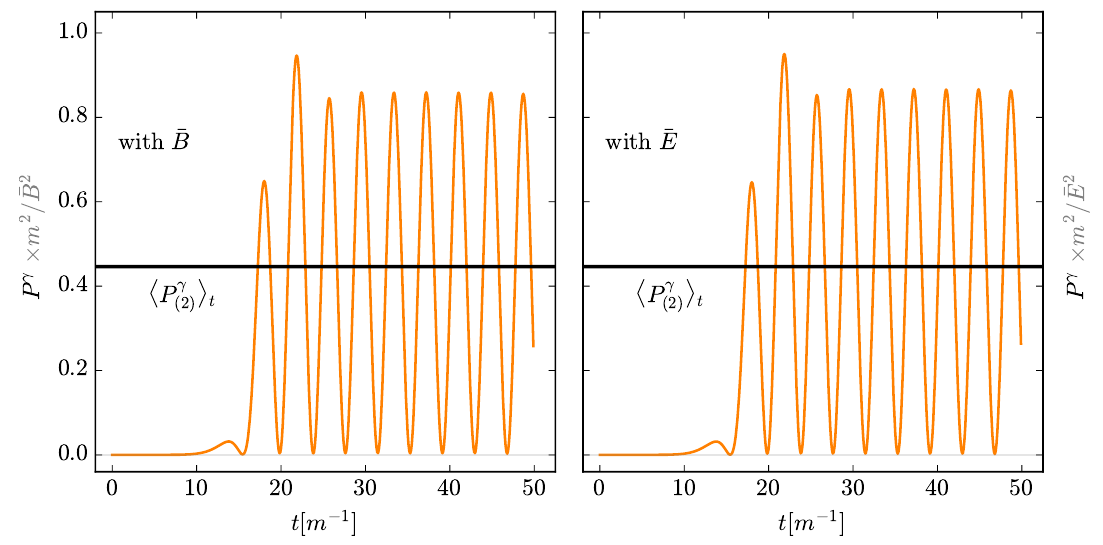
Figure 6 . The radiated electromagnetic power from a dense soliton in constant background E or B field as function of time for C = 0 . 09 . In this regime the radiation is expected to be described well by dipole radiation P γ provided in (4.14). The black lines are the analytic results for the (2) time-averaged power which matches nicely with the numerical results. Note the frequency of 2 ω is expected from analytics as